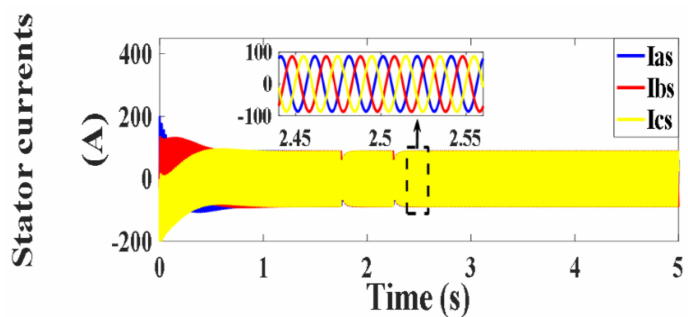
Figure 14. Stator currents under SVOC (A).